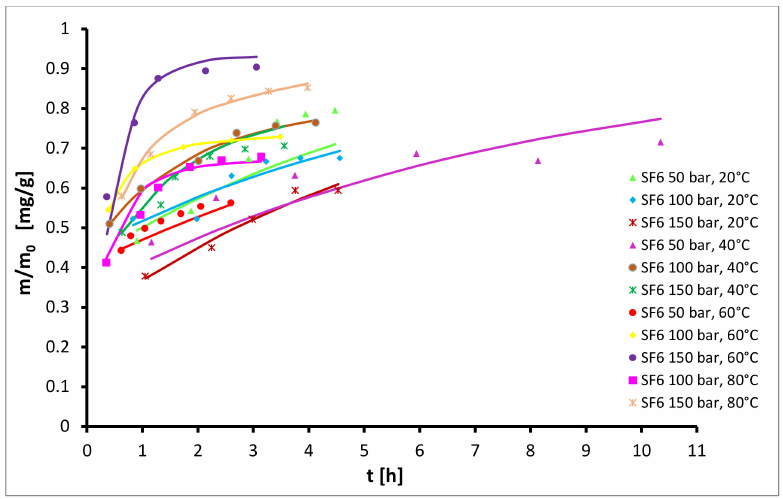
Figure 8. Experimental (symbols) and modelled (lines) kinetic curves for extraction with SF 6 as solvent. High extraction rate was observed at 60 ◦ C and 100 bar and 60 ◦ C and 150 bar where it is obvious that the process is controlled by diffusion from the particle surface. Also the fraction of solute extracted in the first period (0.651 at 100 bar and 0.640 at 150 bar) was higher than in the second period, where the diffusion of solute inside the pores of solid particles to the particle surface is controlling the extraction